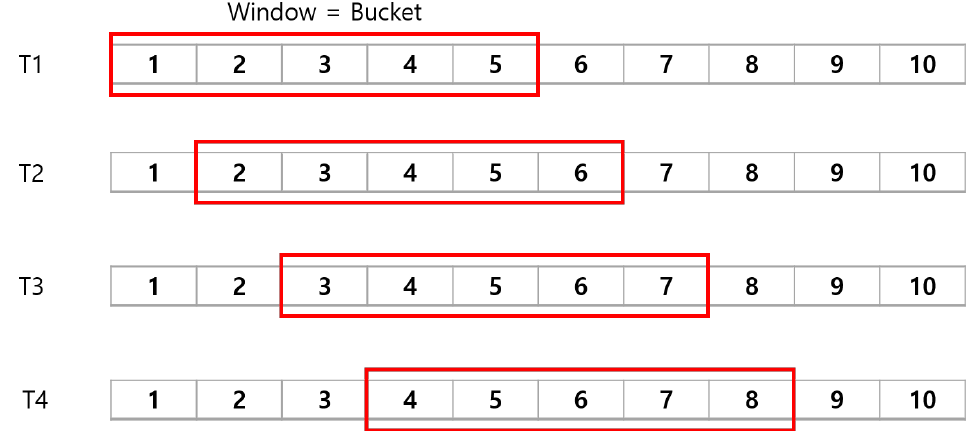
Figure 3. Example of sliding window as a